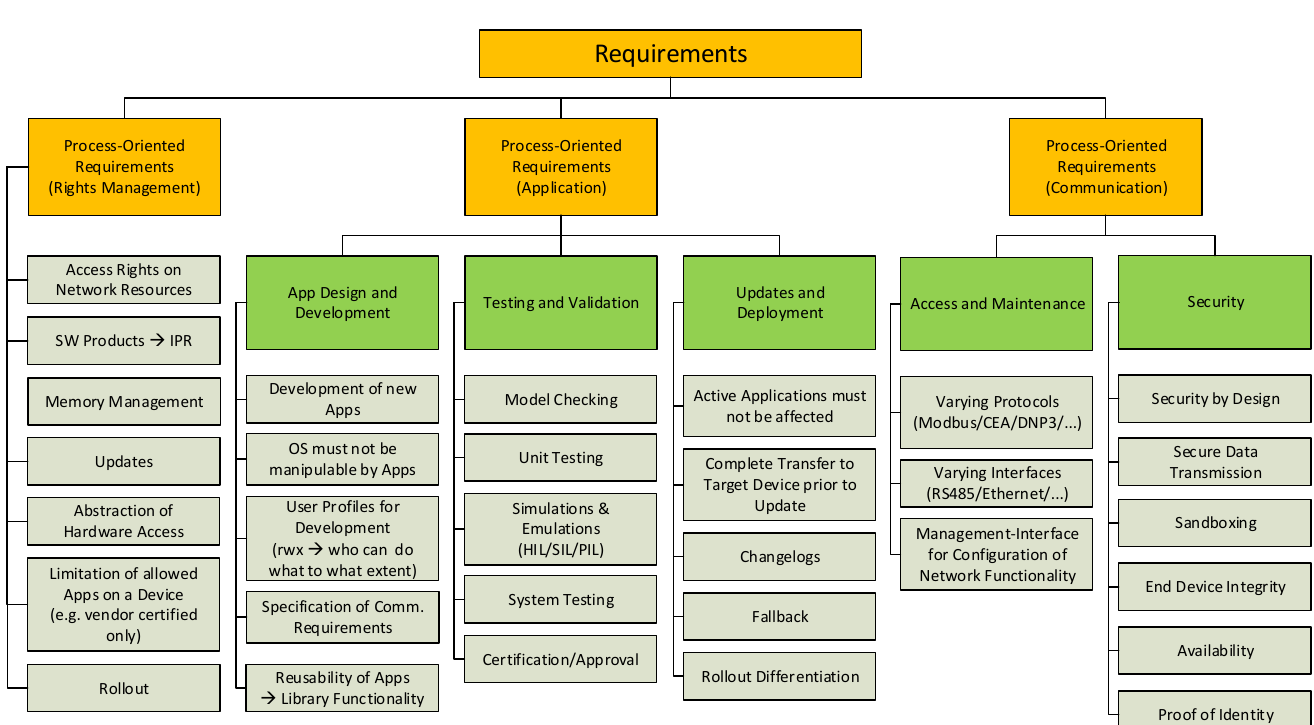
Figure 3. Overview of derived